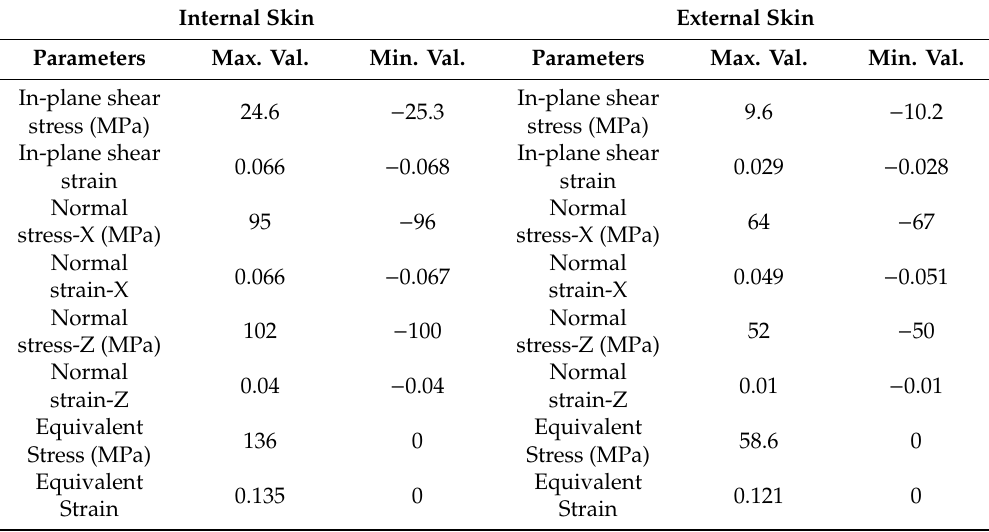
Table 3. Bulk material mechanical properties related to wing model 6% camber change.